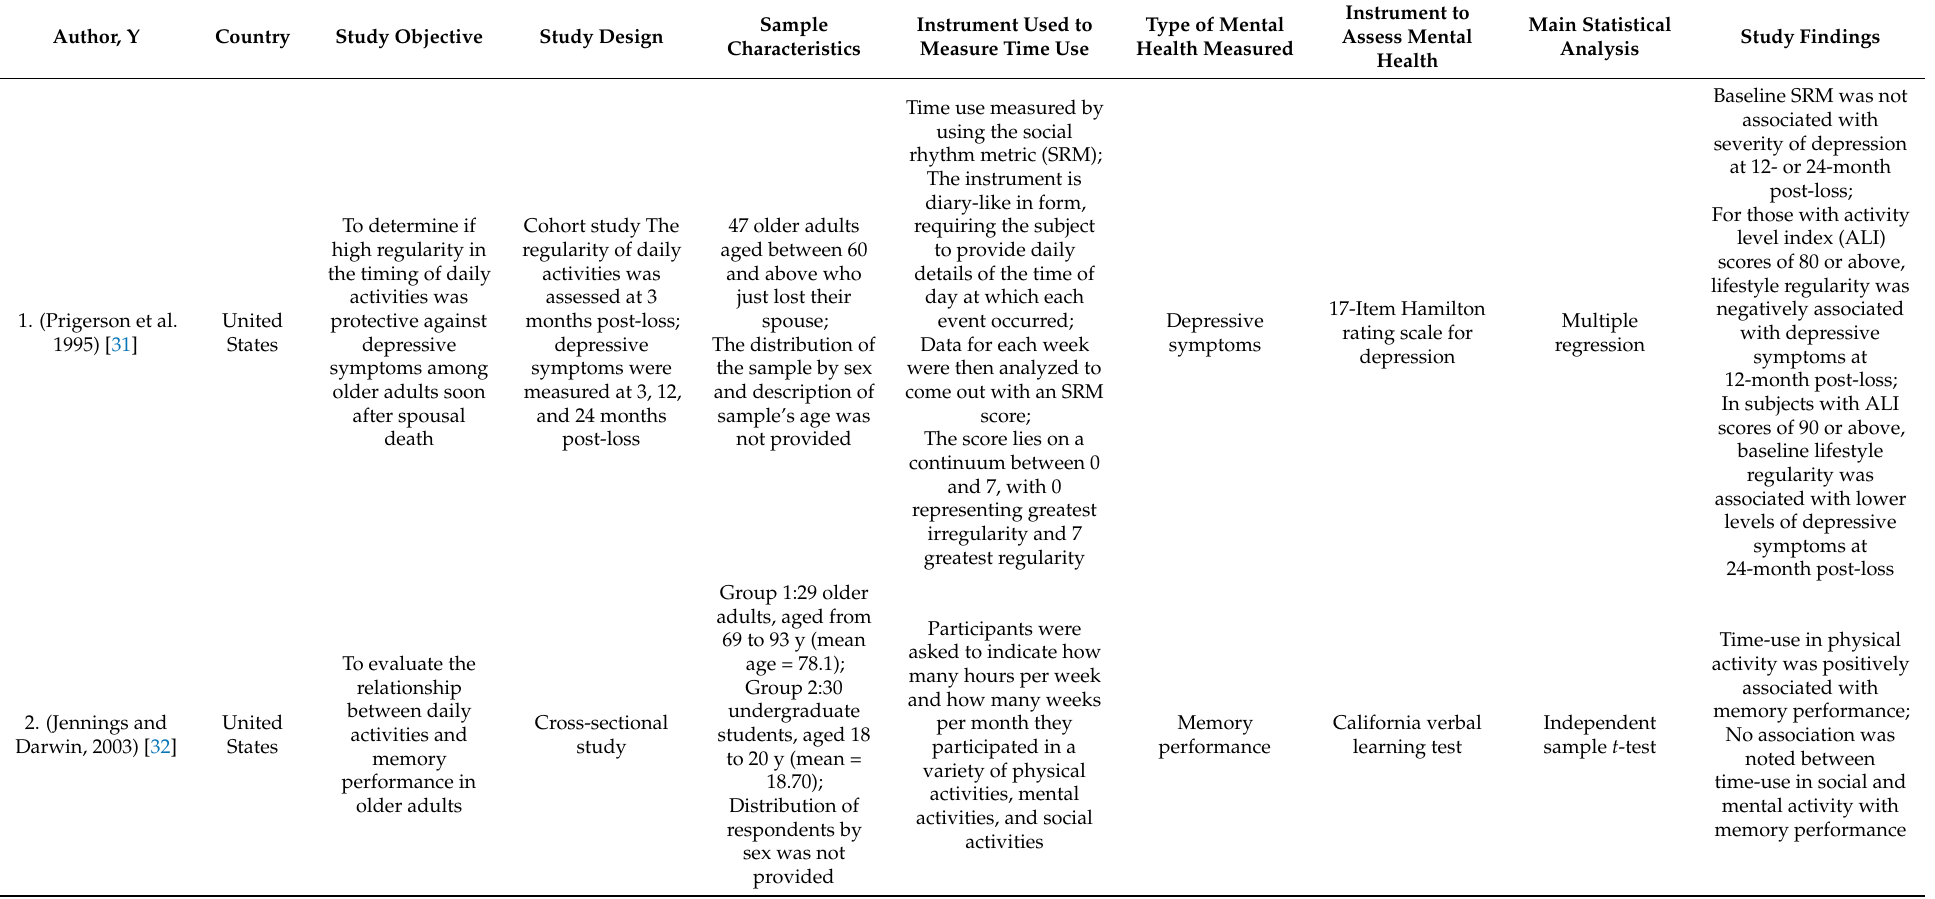
Table 4. Summary of